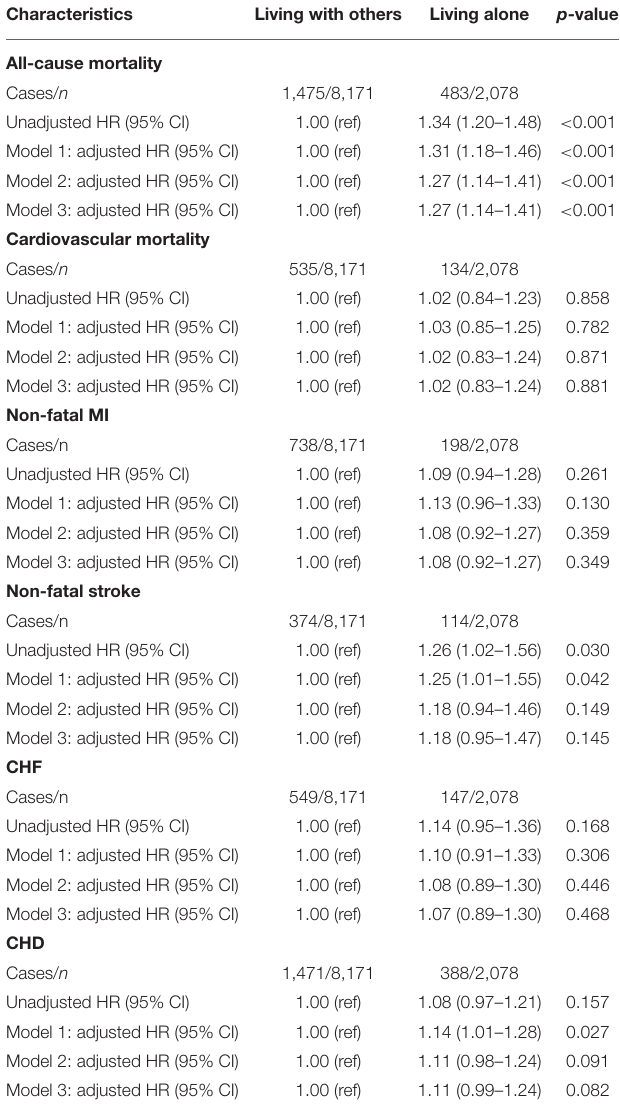
TABLE 2 | The risk of primary and second outcomes in T2DM Patients with different living status. Characteristics Living with others Living alone p